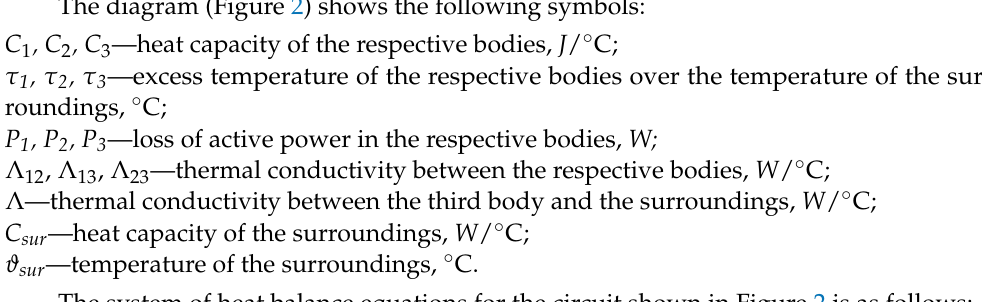
Figure 2. Thermal equivalent circuit of the motor.